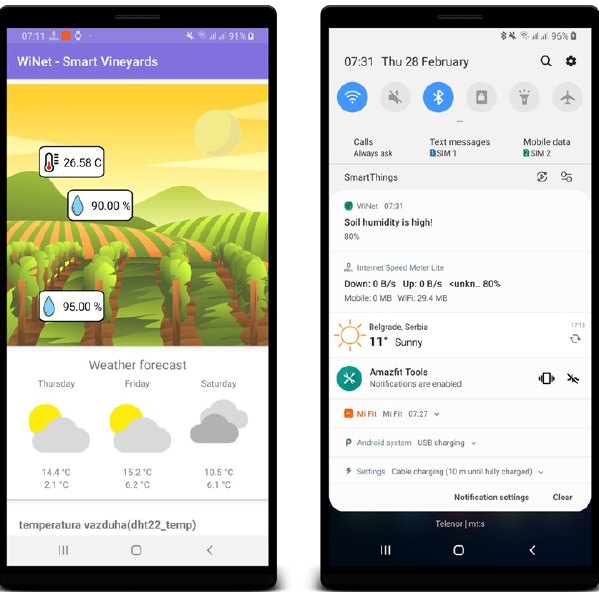
Figure 12. The Winet mobile